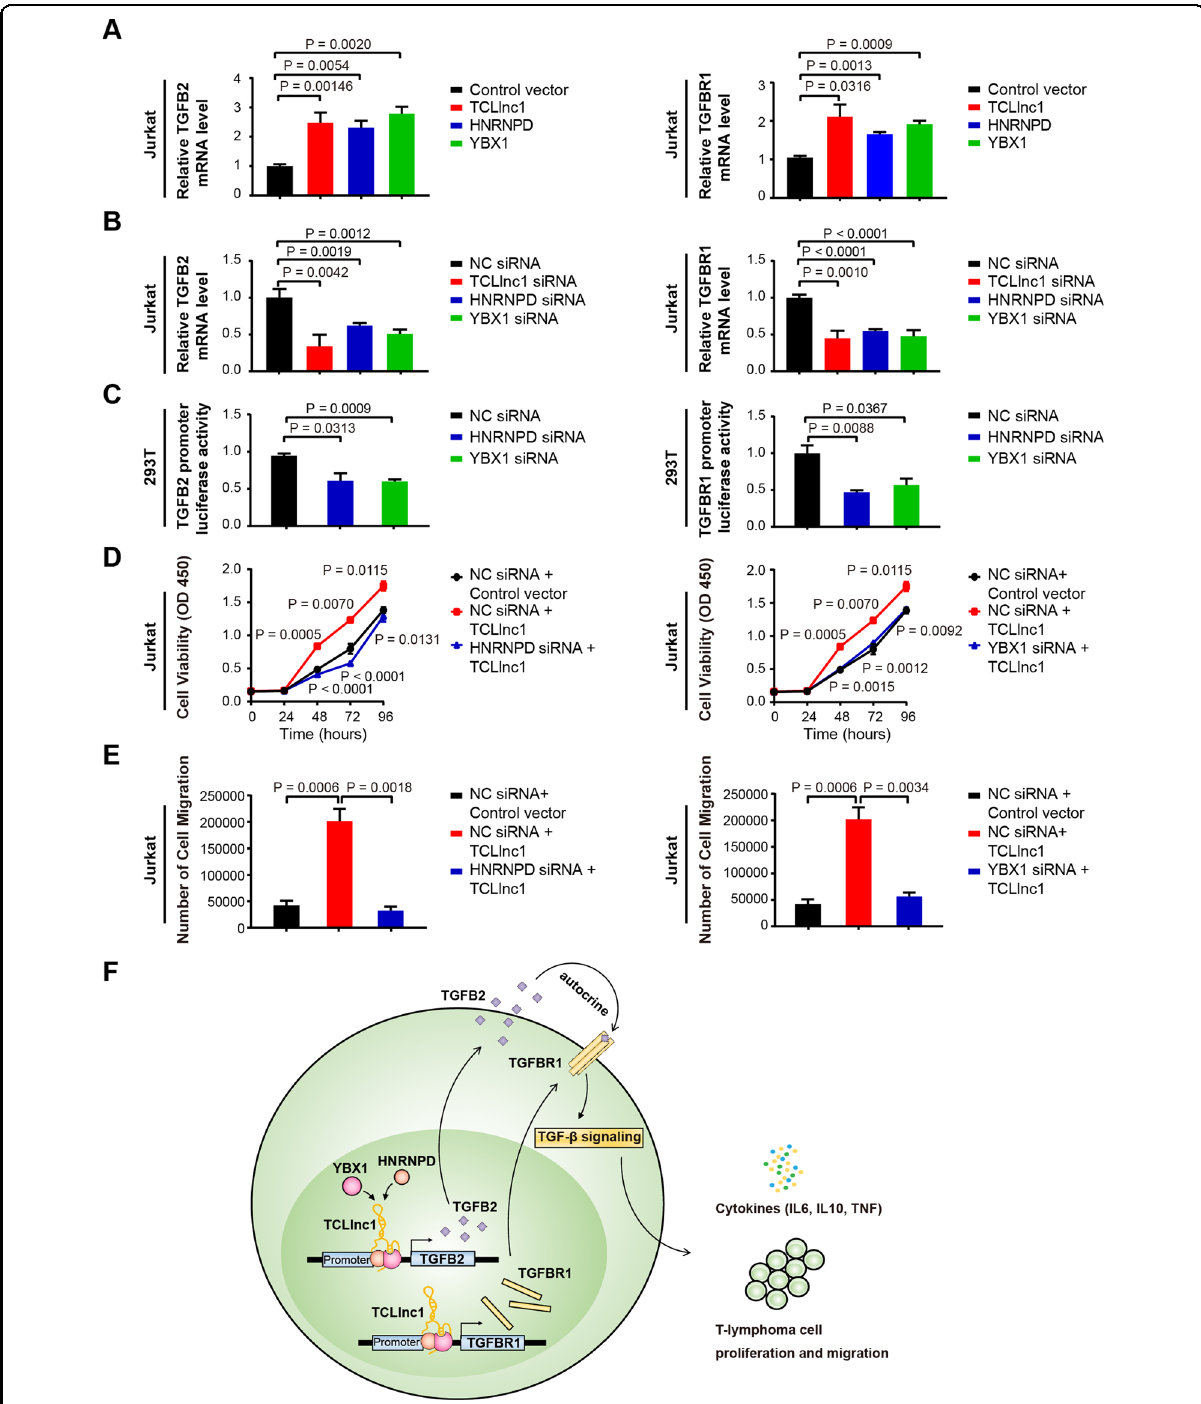
Fig. 7 TCLlnc1 provoked lymphoma progression via HNRNPD and YBX1. A Expression of TGFB2 and TGFBR1 after overexpression of TCLlnc1, HNRNPD, or YBX1 detected by qRT-PCR. B Expression of TGFB2 and TGFBR1 after knockdown of TCLlnc1, HNRNPD, or YBX1 detected by qRT-PCR. C Luciferase activity assay of TGFB2 and TGFBR1 promoter in cells transfected with HNRNPD siRNA, YBX1 siRNA, or NC siRNA. D Proliferation of Jurkat cells after transfection of HNRNPD siRNA or the YBX1 siRNA, plasmid encoding TCLlnc1, or control vector. E Migration of Jurkat cells after transfection of HNRNPD siRNA or YBX1 siRNA, plasmid encoding TCLlnc1, or control vector. F A schematic model of lncRNA TCLlnc1 function in PTCL.